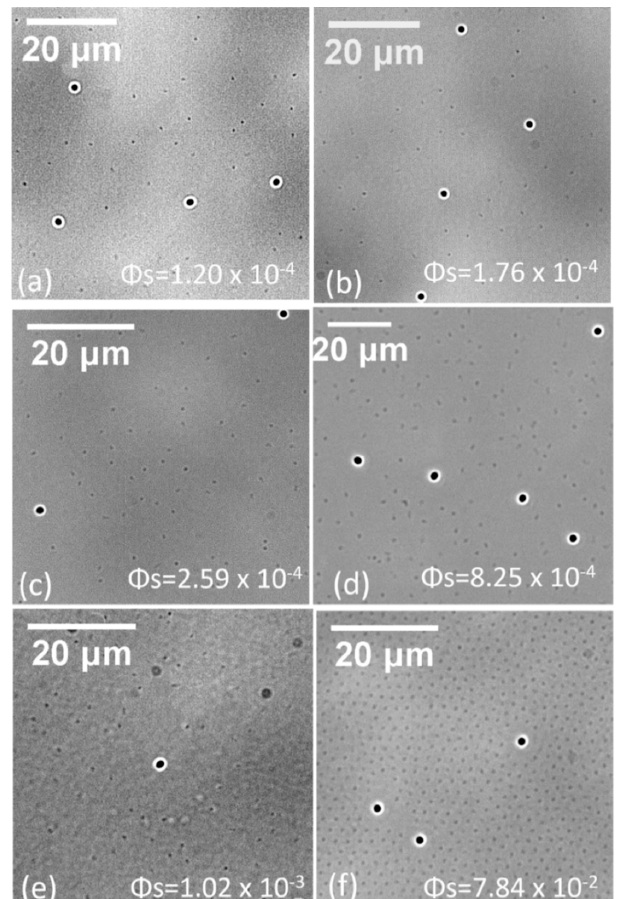
Figure 6 . ( a )-( f ): Images of binary interfacial particles with a fixed concentration of large particles and increasing ϕ s , the concentration of small particles. The small particle structure changed from disordered to ordered as the concentration increased. Separation between large–large particles and large–small particles declined with an increase in the small particle concentration.